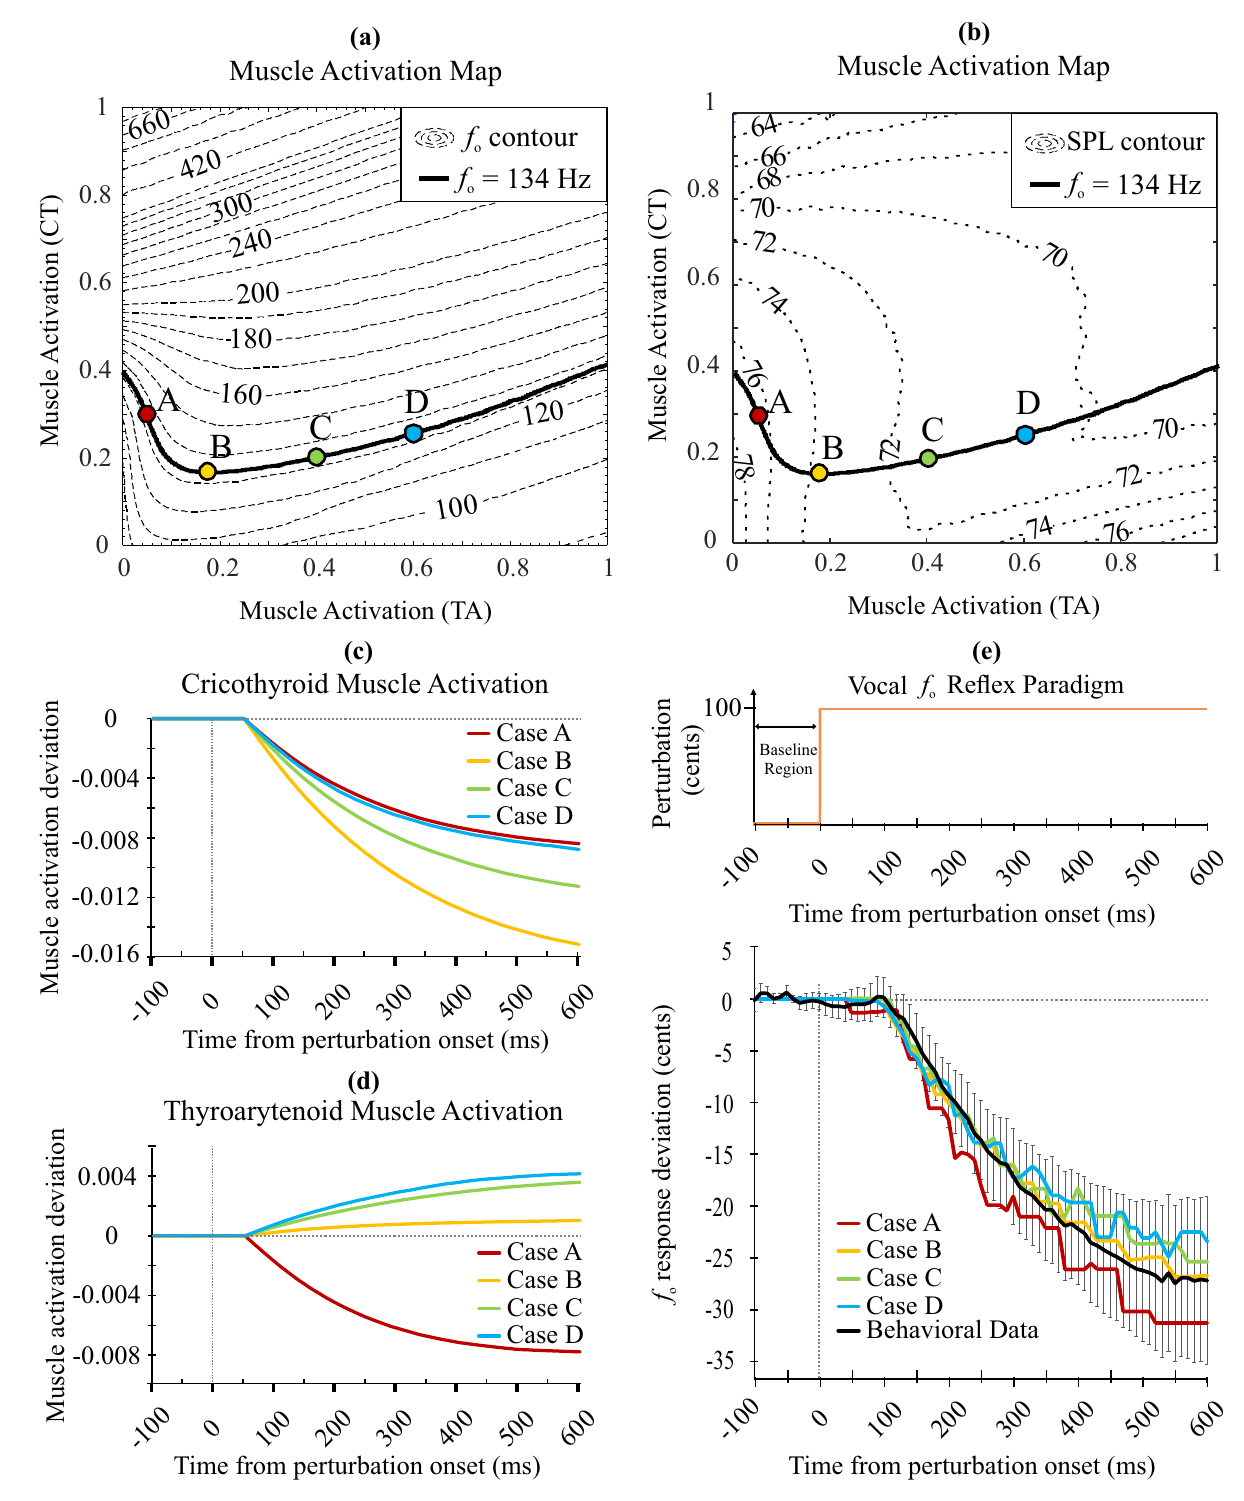
Fig 4. Simulation responses of LaDIVA for four different initial laryngeal muscle activation levels. (a-b) Cases A, B, C, and D muscle activation levels are indicated by dots on the f o = 134 Hz solid line, with subglottal pressure (P s ) = 800 Pa. (a) shows f o contours (Hz units) and (b) shows